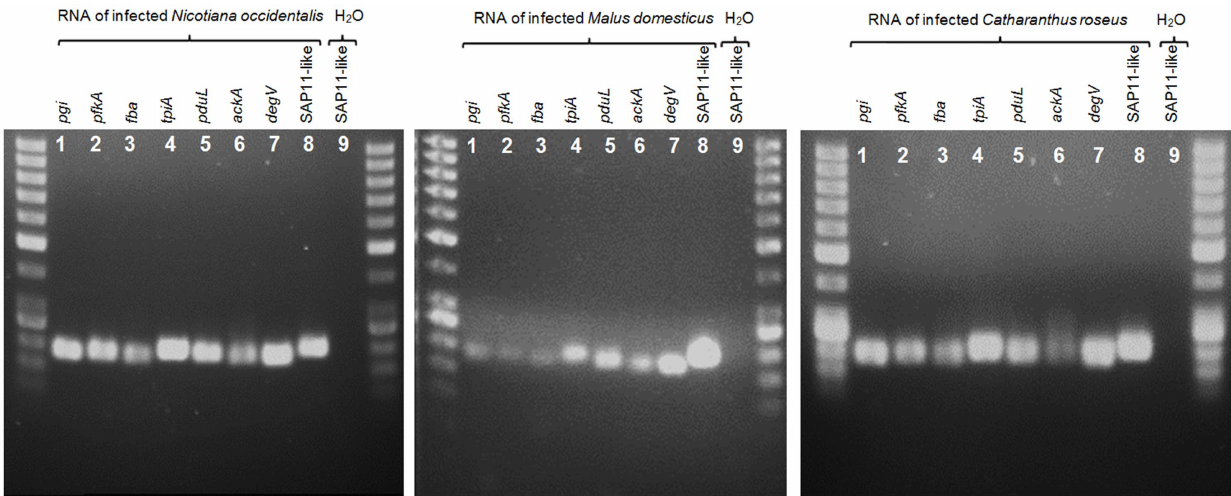
Figure 3. RT-PCR confirming the expression of pgi , pfkA , fba , tpiA , pduL , ackA , degV and SAP11-like gene. RNA was obtained from Nicotiana occidentalis , Malus domestica , Catharanthus roseus infected by ‘ Ca . P. mali’ strain AT. The RT-PCR products were separated on a 1.4% TAE agarose gel. Lane number nine was used for negative control applying water as template (example SAP11-like gene). The product size of around 200 bp was estimated by the 50 bp DNA ladder (Lifetechnologies) loaded on first and last lane of each gel.